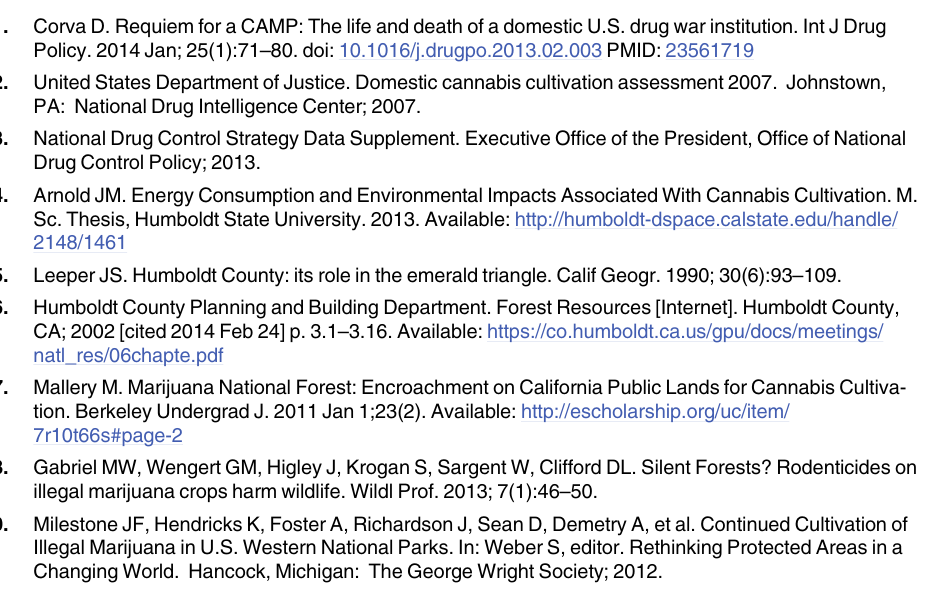
S1 Table. Number of outdoor plants counted, area of greenhouses measured, and estimated water use in Liters per day for each parcel in the study watersheds. S2 Table. Per-watershed daily water demands compared to seven-day low flow by